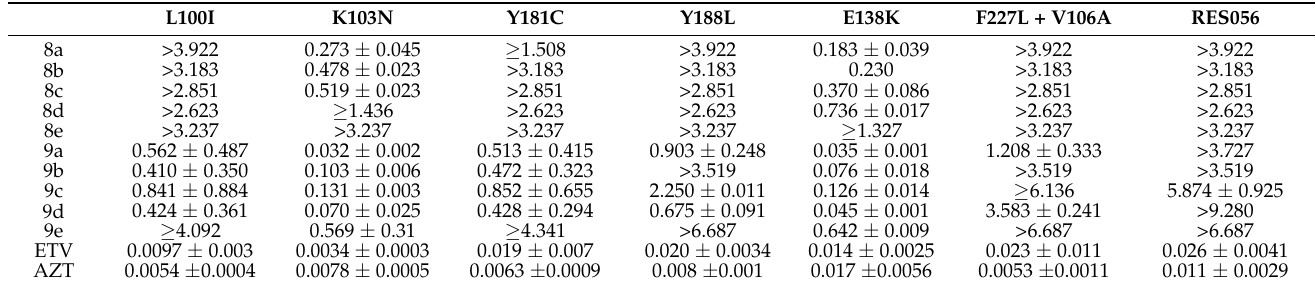
Table 3. Anti-HIV-1 Activity against Mutant Strains in MT-4 Cells